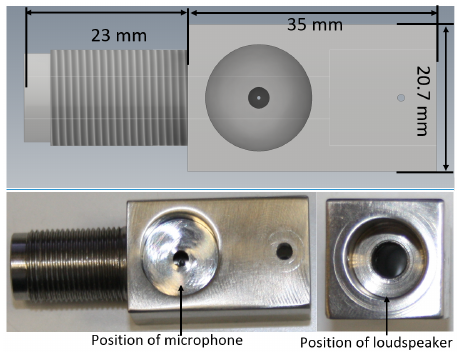
Figure 7. CAD model and photo of the acoustic connector.